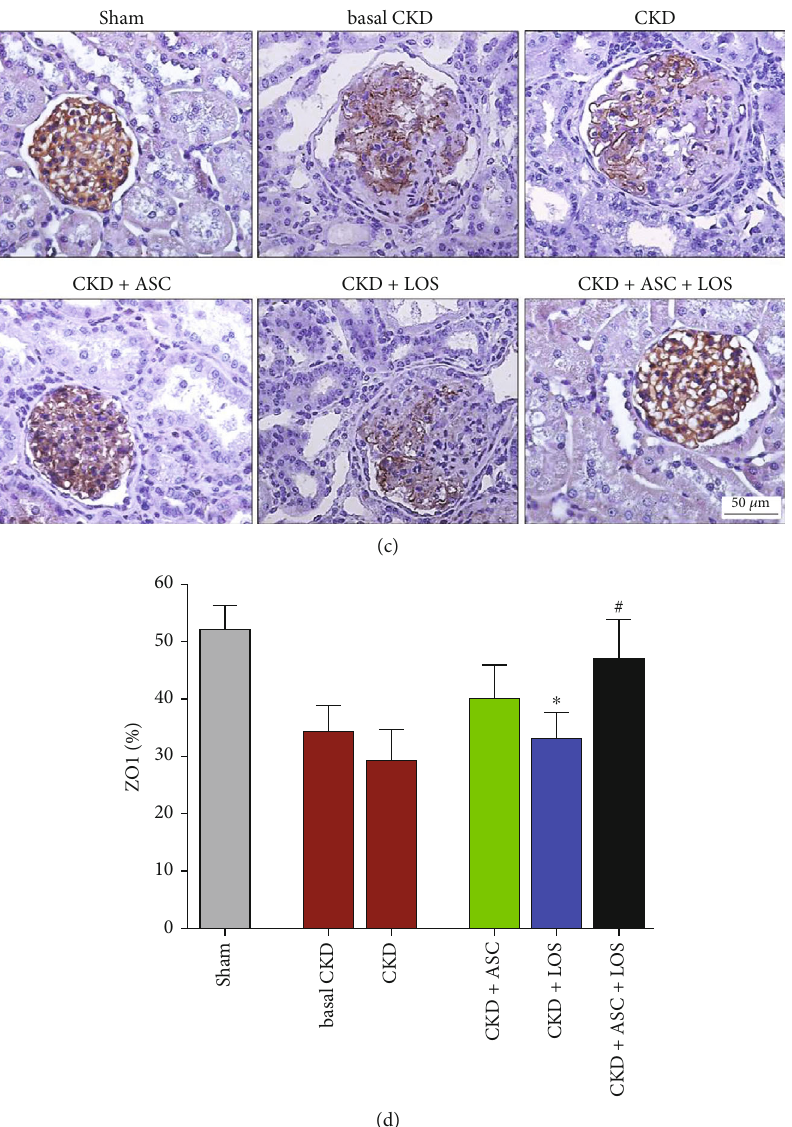
Figure 3: Glomerular architecture. (a) Illustrative microphotographs of PAS stained sections of the animals of each experimental group, at the end of the study. (b) Bar graphs of the percentage of glomerulosclerosis (GS) in the animals included in the protocol. (c) Illustrative microphotographs of immunohistochemistry for ZO1 in each experimental group. (d) Bar graphs of the percentage of glomerular area occupied by ZO1 in the animals included in each experimental group, at the end of the study. Statistical di ff erences are ∗ p < 0 : 05 vs. Sham, § p < 0 : 05 vs. basal CKD, # p < 0 : 05 vs. CKD, † p < 0 : 05 vs. CKD+ ASC, and ‡ p < 0 : 05 vs. CKD+